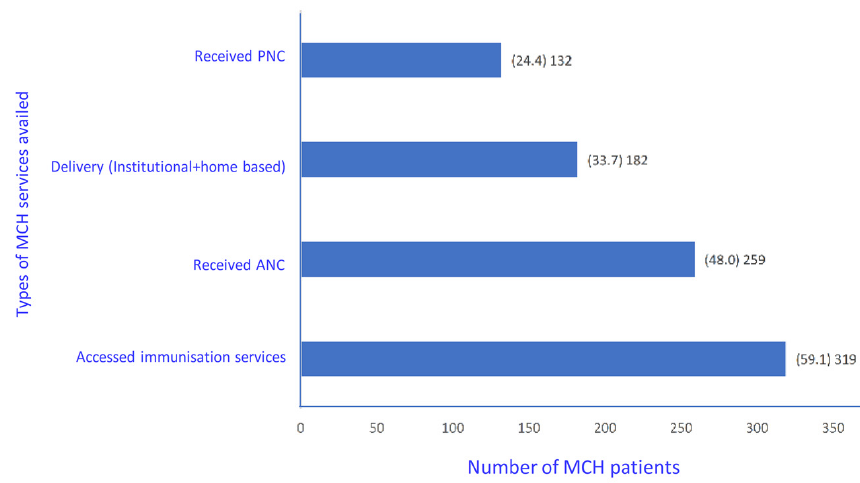
Figure 2. Distribution of patients based on the MCH services accessed in six states of India, March- June 2020 (n = 540). MCH Patients might be eligible for multiple services hence the sum is higher than 540. MCH—maternal and child health, ANC—antenatal care, PNC—postnatal care received by mother. Table 1. Sociodemographic profile of the patients (n = 540) from six states of India, March–June 2020.